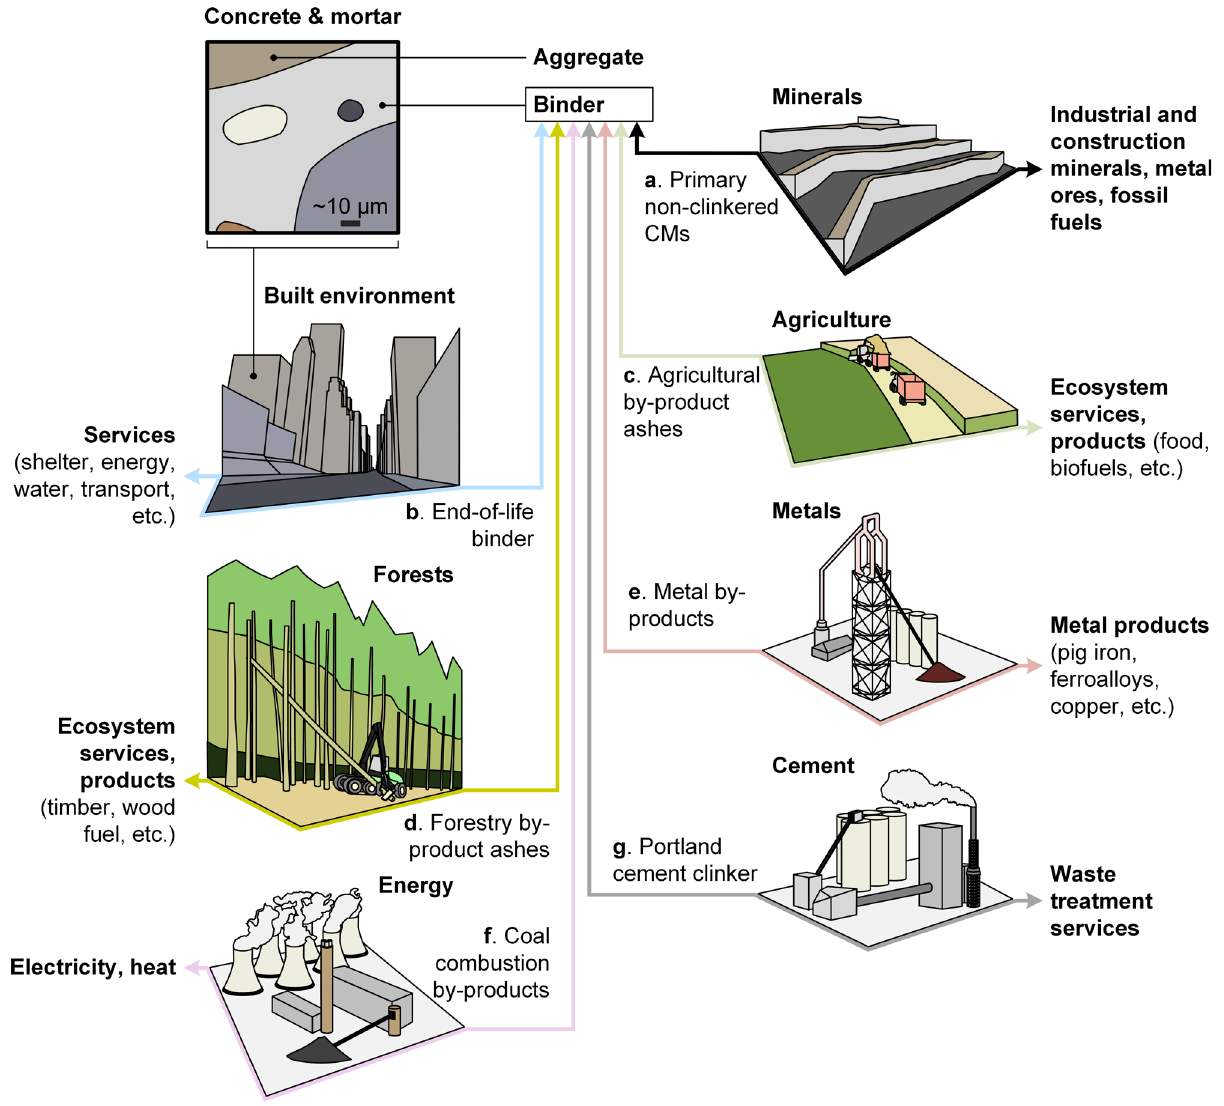
Fig. 1 | Conceptual representation of clinker and cement substitution. Sub- stitutioninthecementitiousbinder,andinmortarandconcrete(productscale,top left), is linked in several important ways to the wider industrial system (market